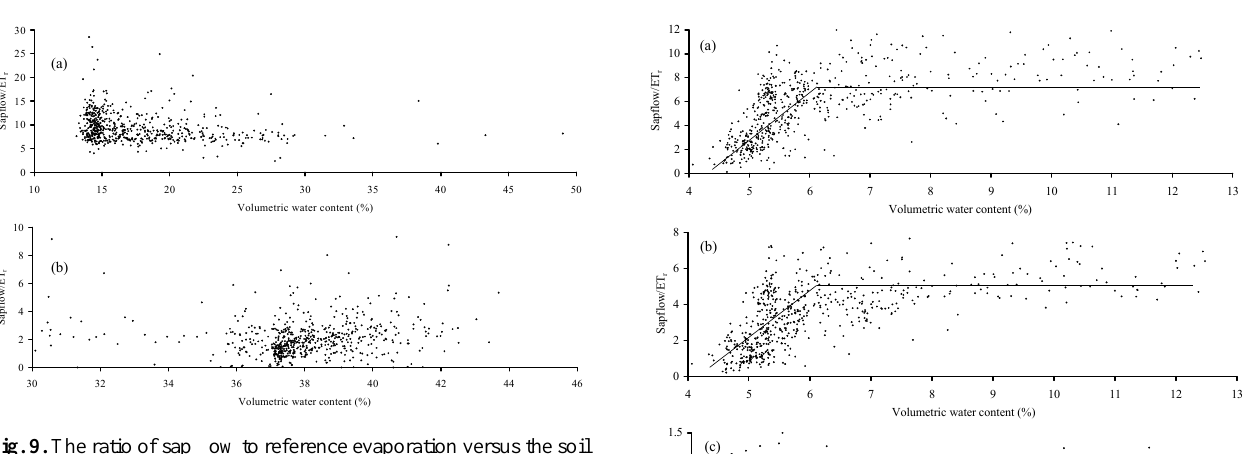
Fig. 9. The ratio of sap flow to reference evaporation versus the soil water content (0.075m) at the peat swamp forest site for (a) Syzy- gium cordatum and (b) Shirakiopsis elliptica .